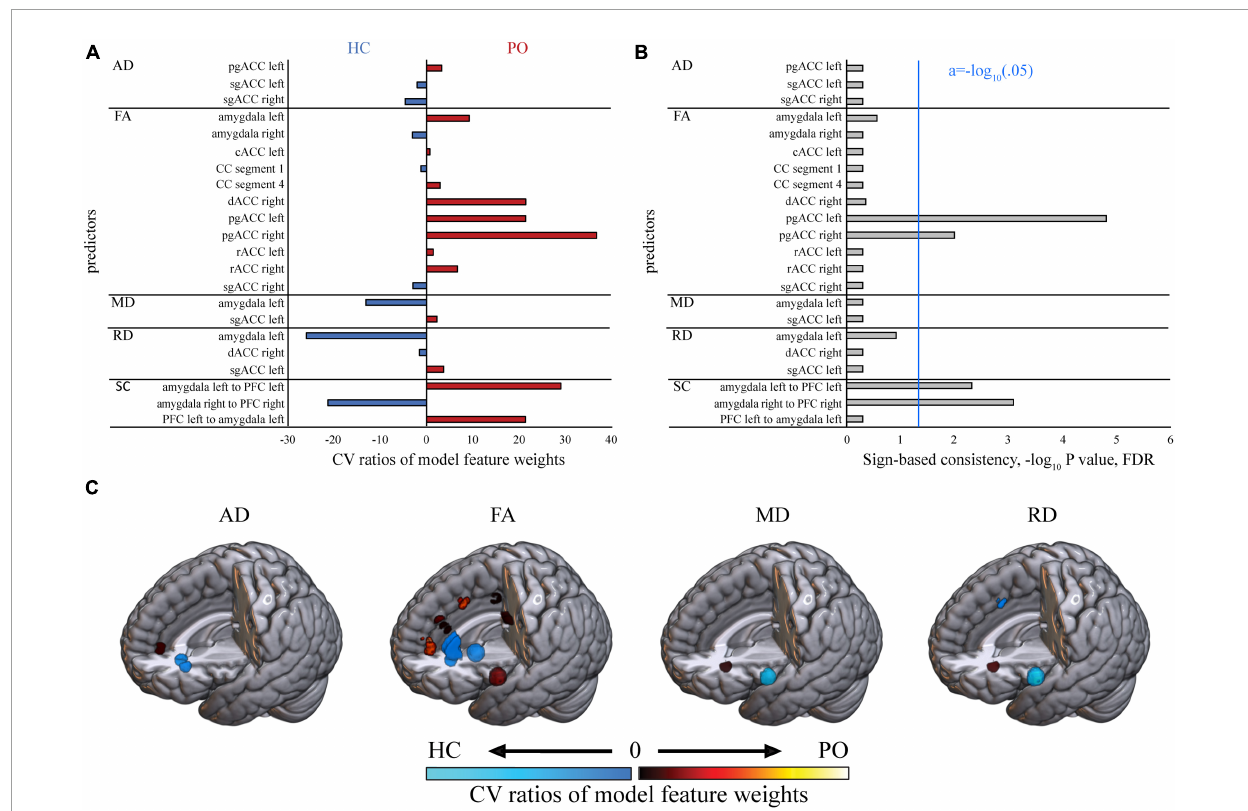
FIGURE1 Discriminative brain pattern of the PO model. (A) Depicted are the CV ratios (CVRs) of the feature weights of the PO model, sorted by DTI modality. Positive CVRs, predictive of PO individuals, are displayed in red, and negative CVRs, predictive of HC, are displayed in blue. (B) Depicted are the P -values, computed via sign-based consistency mapping. P -values surpassing the FDR-adjusted threshold indicate which features were consistently weighted in the same direction (positively or negatively) exceeding chance level across all computed CV models. (C) The open-source 3-dimensional rendering software MRIcroGL (McCausland Center for Brain Imaging, University of South Carolina; https://www.nitrc.org/projects/mricrogl/) was used to overlay the CVR maps on the Montreal Neurological Institute single-participant template and produce 3-dimensional renderings. The cool color scale indicates lower (i.e., predictive of HC individuals) and the warm color scale higher (i.e., predictive of PO individuals) CVRs. SC, structural connectivity; FA, fractional anisotropy; RD, radial diffusivity; AD, axial diffusivity; MD, mean diffusivity; HC, healthy control individuals; PO, pedophilic offender individuals; cACC, caudal anterior cingulate cortex; dACC, dorsal anterior cingulate cortex; rACC, rostral anterior cingulate cortex; sgACC, subgenual anterior cingulate cortex; pgACC, pregenual anterior cingulate cortex; CC, corpus callosum; PFC, prefrontal cortex; CVR, cross validation ratio.